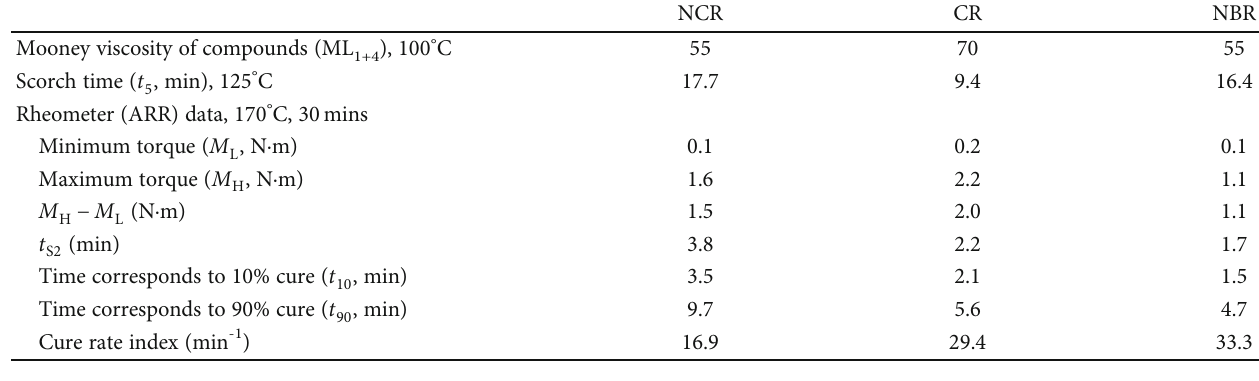
Table 3: Mooney viscosity, scorch, and cure characteristics of acrylonitrile-chloroprene rubber (NCR), chloroprene rubber (CR), and nitrile rubber (NBR).